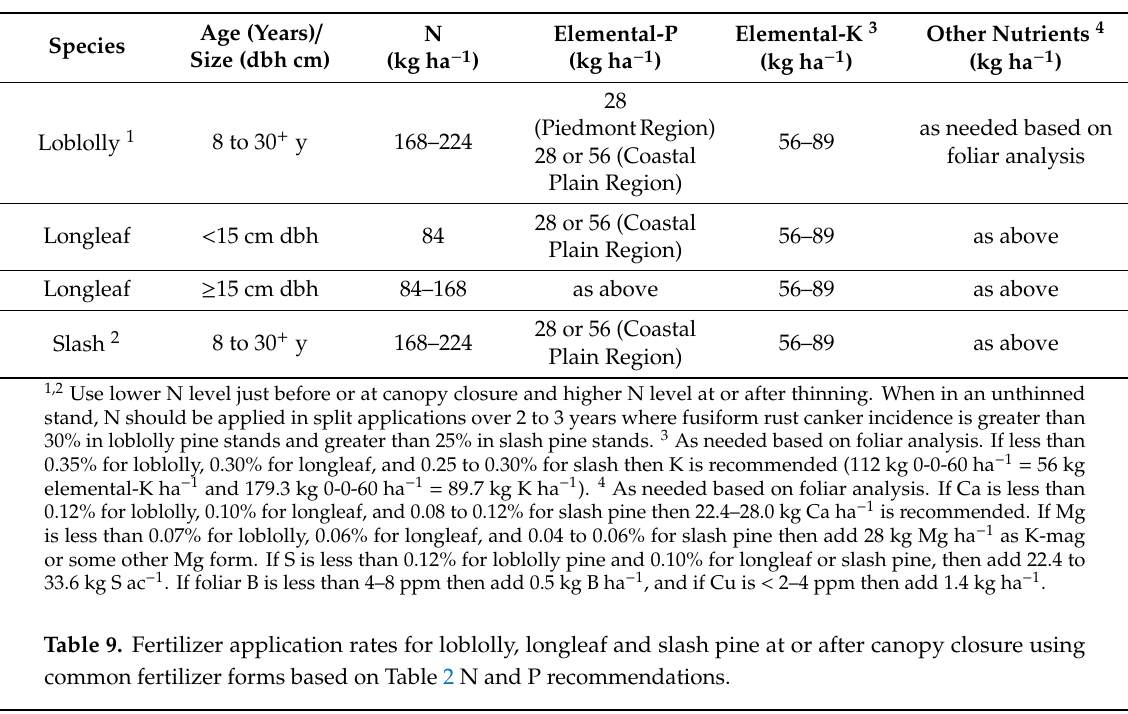
Table 8. Recommended fertilizer rates for a five-year application regime.